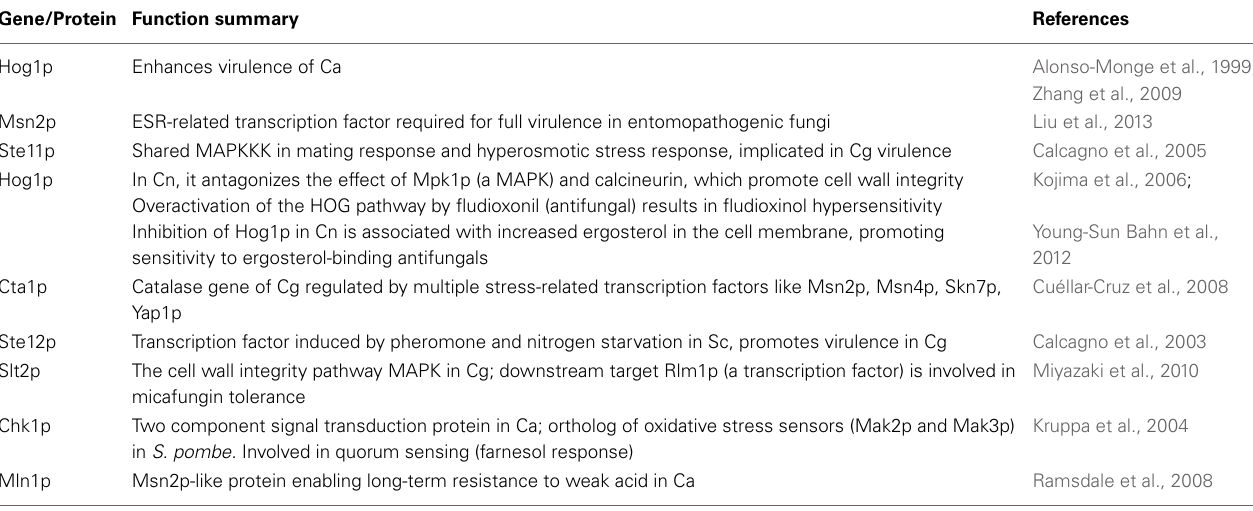
Table 1 | Proteins involved in osmoadaptation/stress responses as well as other phenotypes in pathogenic fungi. Gene/Protein Function